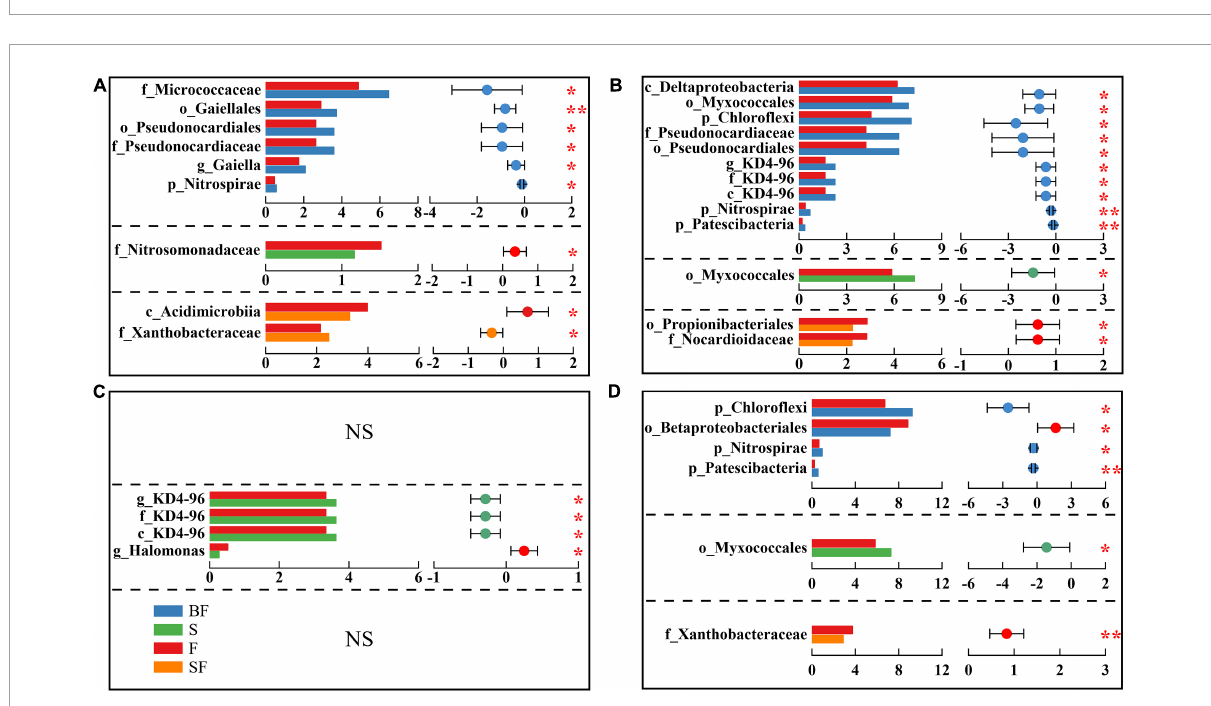
FIGURE5 Inter-group difference test for relative abundance of bacteria. Panels (A–D) represent 0–10 cm seedling stage, 0–10 cm maturity stage, 10–20 cm seedling stage, and 10–20 cm maturity stage, respectively. The letters before bacterial names represent the abbreviations for different taxonomic levels (k-Kingdom, p-phylum, c-class, o-order, f-family, g-genus). The horizontal axis of histogram represents the average relative abundance of bacteria. Student’s t -test was used to assess significant differences between groups. The horizontal axis of the scatter plot represents the difference between the average relative abundances of bacteria for the two treatments, and the error bars are 95% confidence intervals. * p < 0.05, ** p <